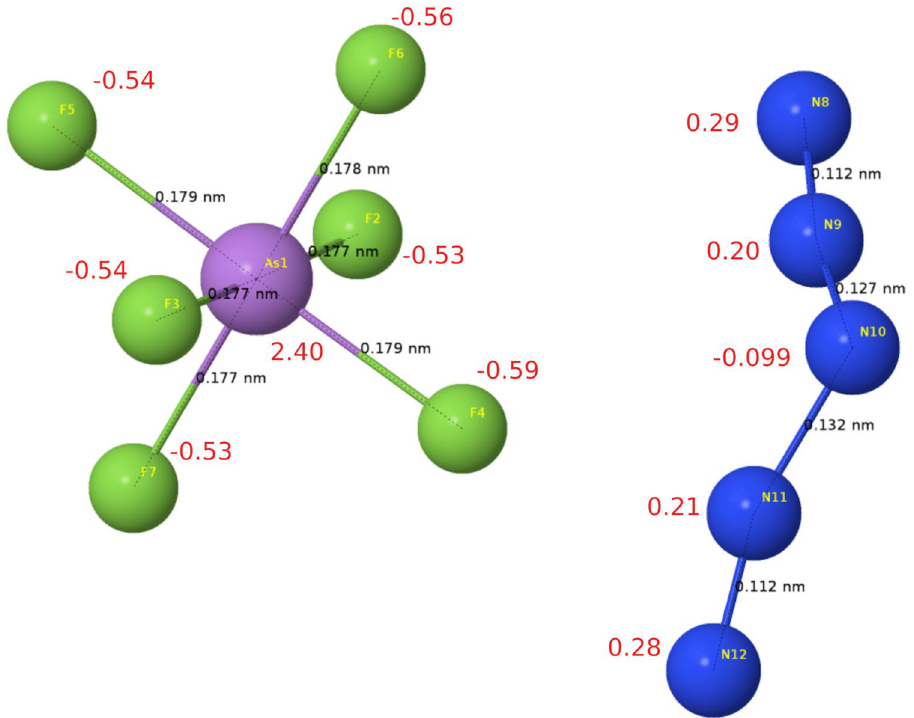
Figure 5. Bond lengths and natural charge of the two molecular units of N 5 AsF 6 from natural bonding orbital (NBO) analysis. Further comparisons to the only known N + 5 salt is shown in Table